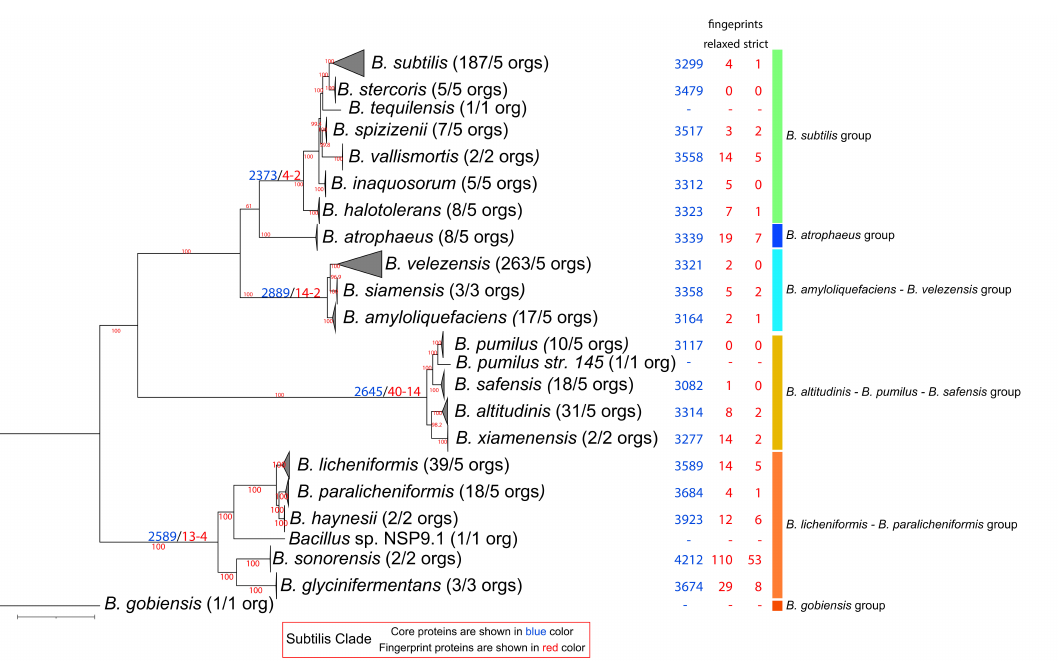
Figure 2. Phylogenomic ML tree (IQ-Tree2-Q.Plant + I + F + G4-aLRT) of the Subtilis Clade based on 457 core protein-orthologous groups from 634 proteomes. For ease of visualization, certain evolutionary clusters have been collapsed. The full tree is available as Supplementary Figure S2. Next to the species name, in parentheses, is the number of complete genomes that are available and, on their right, is the number of genomes used in the normalized dataset. Further to the right of the species names and at the common ancestor of a lineage, with blue and red colors we denote the number of core and relaxed/strict fingerprint proteins for each lineage (based on the normalized